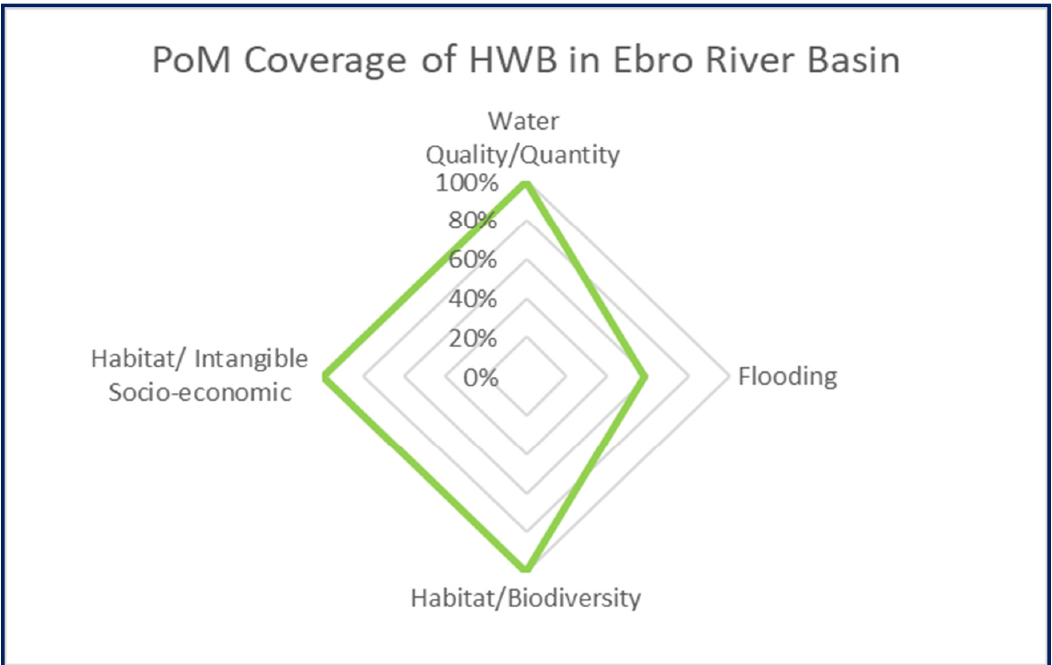
Figure 6. The coverage of HWB factors within the Ebro River Basin.